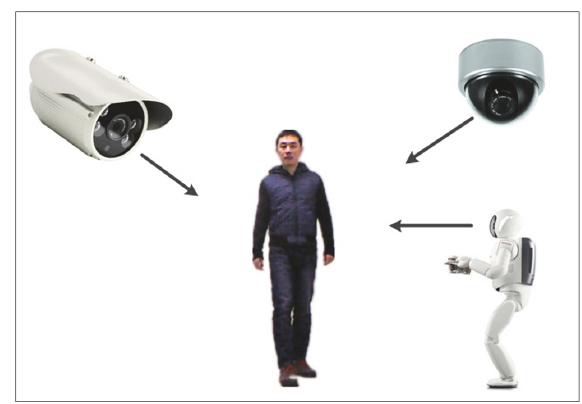
Figure 3: Illustration of multiview situation from sensor network in intelligent